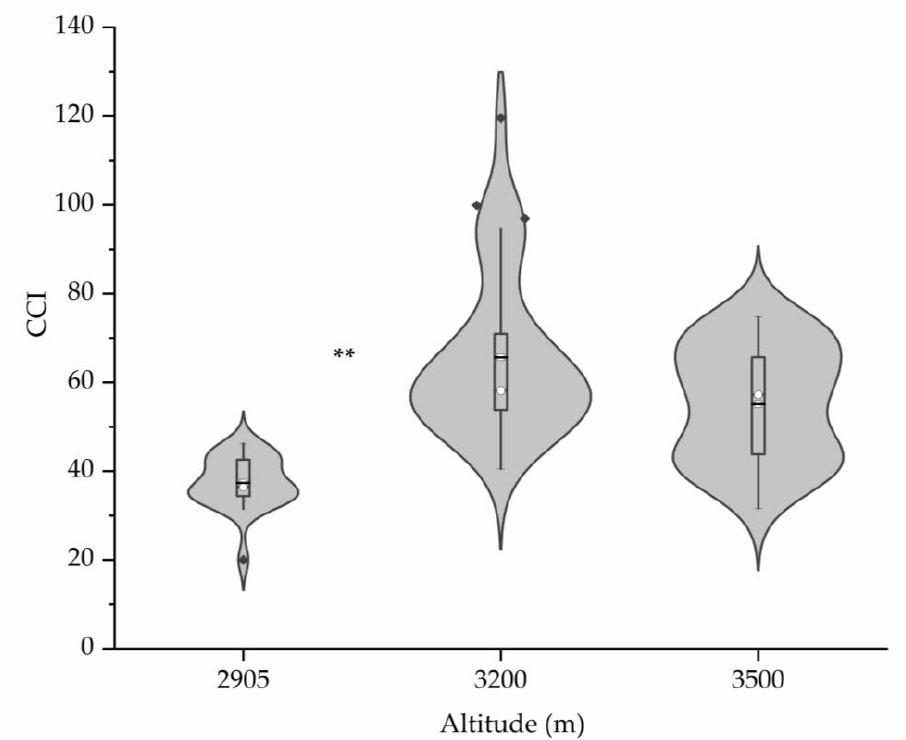
Figure 2. Relative chlorophyll content of Quercus aquifolioides at different altitudes. ** indicates that the parameters are significantly different at p < 0.01 level. CCI (chlorophyll content index).